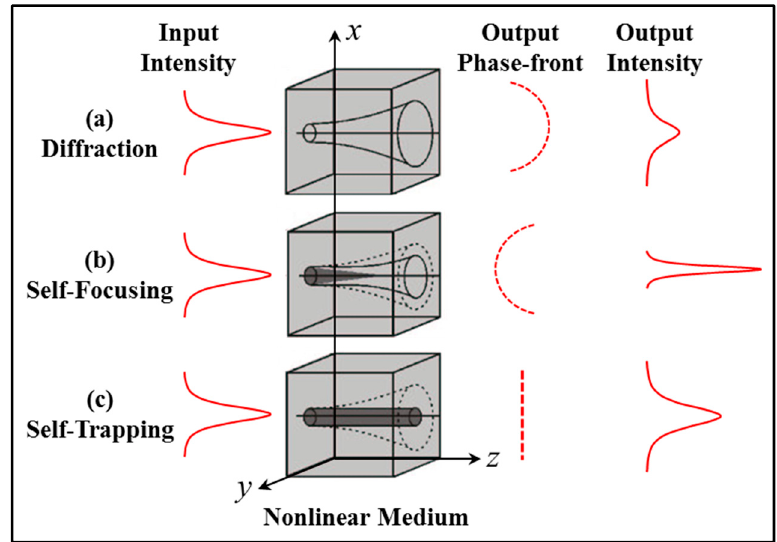
Figure 12. Schematic illustrations of the spatial beam profiles, output phase-front, and output intensity of a propagating beam as it undergoes: ( a ) natural diffraction; ( b ) self-focusing; and ( c ) self-trapping.